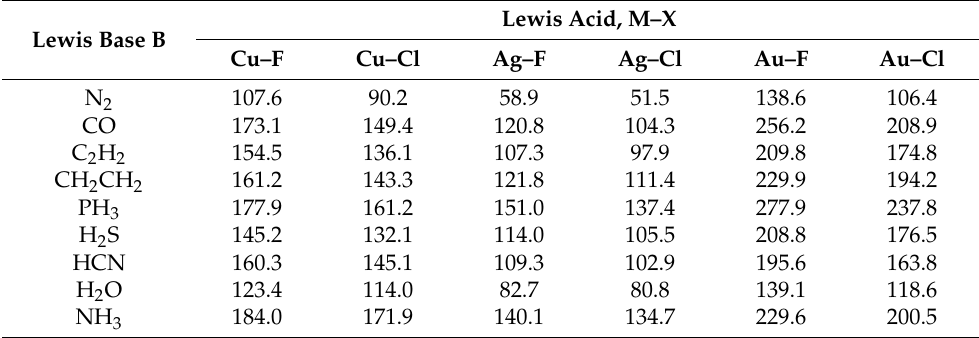
Table 1. Equilibrium dissociation energies D CBS e /(kJ mol − 1 ) calculated at the CCSD(T)/CBS level (see text) for 54 complexes B · · · M–X.